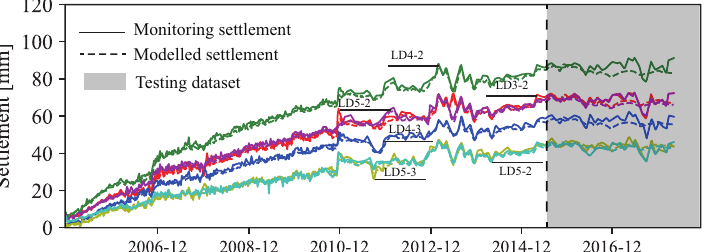
Figure A3. Fitting and prediction results of M–LSTM model based on the training datasets in Cluster 3 (LD2-3 in red, LD3-4 in green, LD5-5 in blue, and LD6-4 in purple lines, respectively).